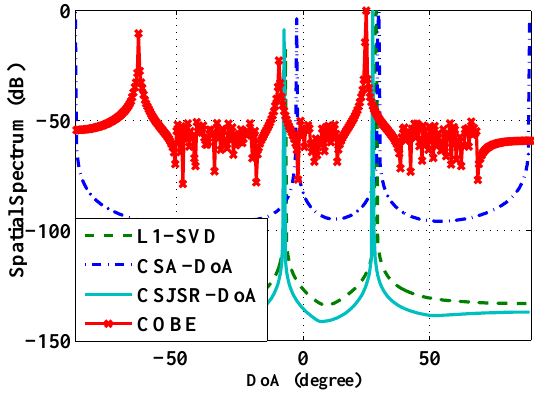
Figure 12. Prototype system experiment of the CSJSR-DoA approach.